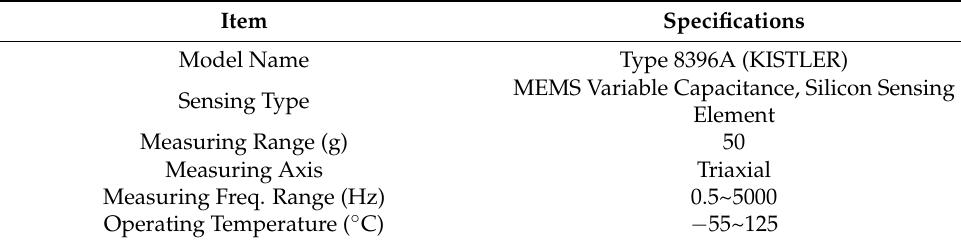
Table 5. Specifications of the used accelerometers.